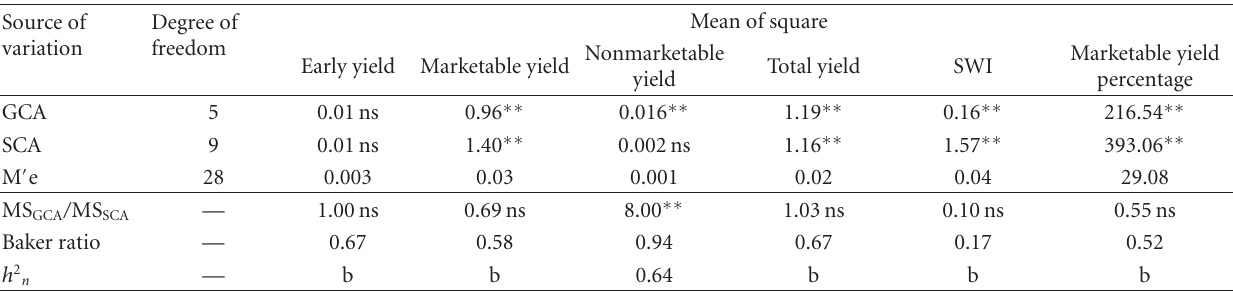
Table 4: Mean squares from diallel analysis for various characters in cucumber (Gri ffi ng’s model I Method 4). Source